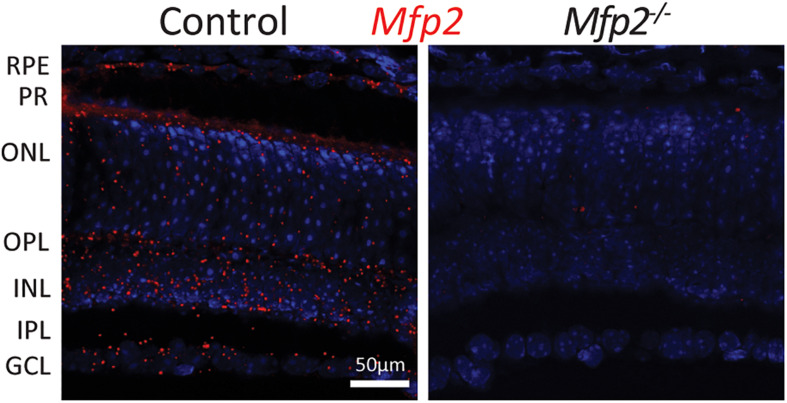
Spatial distribution of Mfp2 transcripts in the mouse retina. Representative images of RNAscope®
in situ hybridization reveals extensive Mfp2 expression throughout the retina of 9 weeks-old Mfp2+/+ mice, but not in Mfp2–/– mice (n = 3 per genotype). Nuclei were counterstained with Hoechst (blue). RPE, retinal pigment epithelium; PR, photoreceptor layer; ONL, outer nuclear layer; OPL, outer plexiform layer; INL, inner nuclear layer; IPL, inner plexiform layer; GCL, ganglion cell layer.